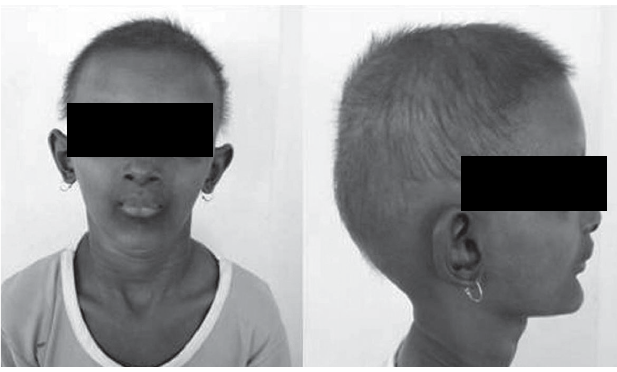
Fig. 1: Frontal and lateral initial views of the patients